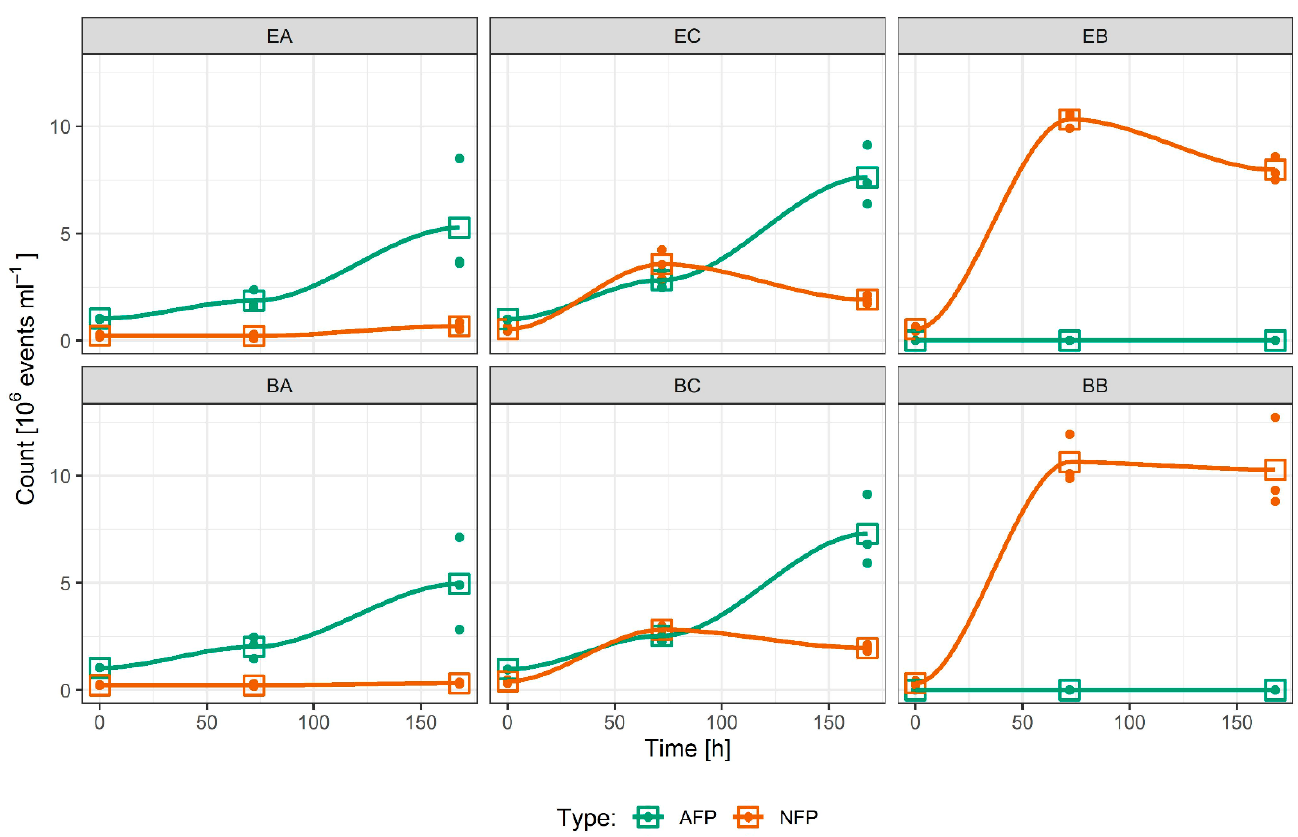
Figure 1. Flow cytometer scatter plots showing growth of cultures: experimental series (addition of BPs): axenic microalgae (EA), co-culture of microalgae and bacteria (EC) and bacterial culture (EB); blank control series (no addition of BPs): axenic microalgae (BA), co-culture of microalgae and bacteria (BC) and bacterial culture (BB). Microalgae are presented by autofluorescent events (AFPs) whereas bacteria and SCPs are presented by non-fluorescent events (NFPs). Single observations are shown as dots, whereas the mean value of three replicates is presented as an empty